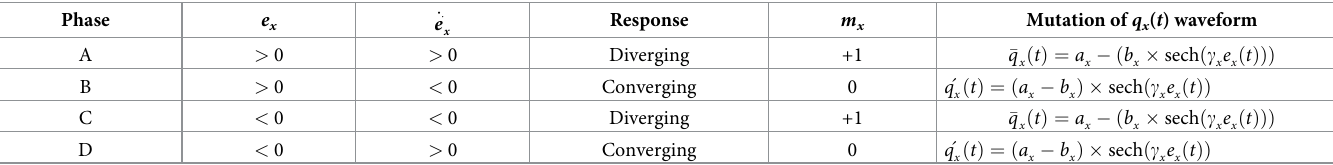
Table 4. Mutation of weight-adjusting